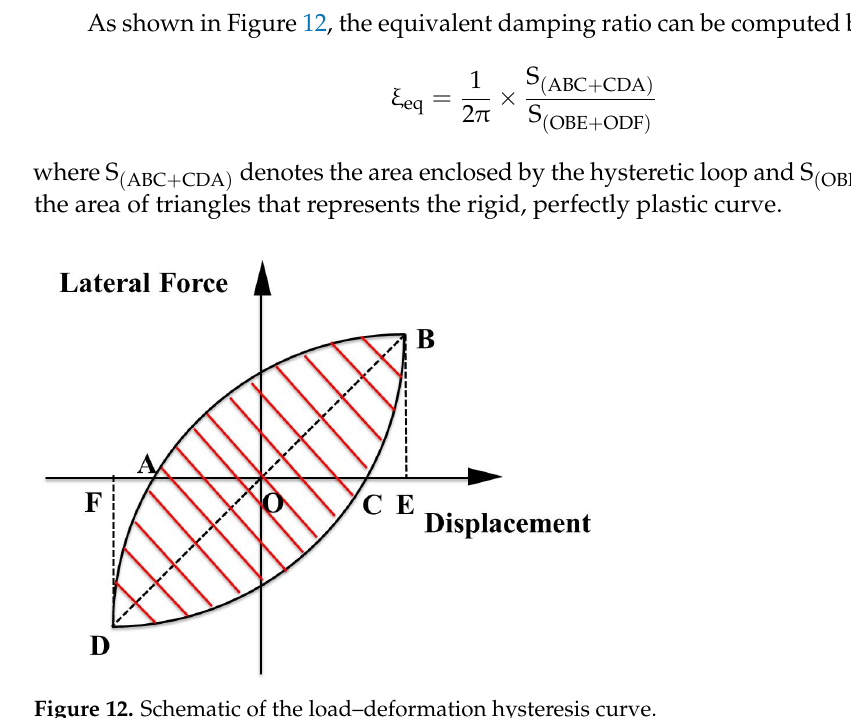
Figure 13. Equivalent viscous damping of the tested